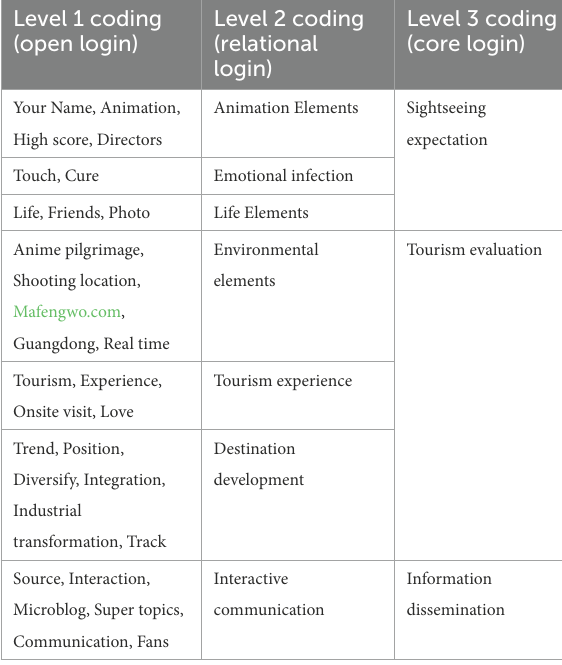
TABLE 4 Coding of interactive elements of Interest-related community based on